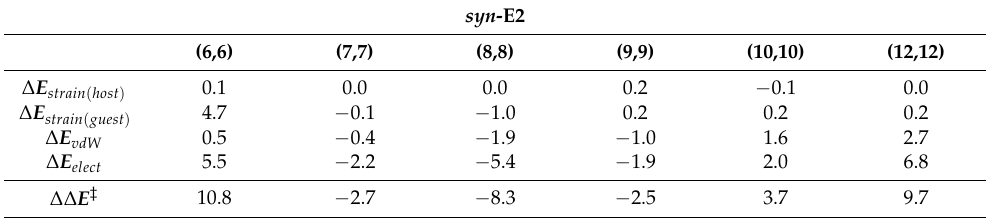
Table 6. Energy contributions (kcal mol − 1 ) to the overall confinement effect on the syn -E2 kinetics.